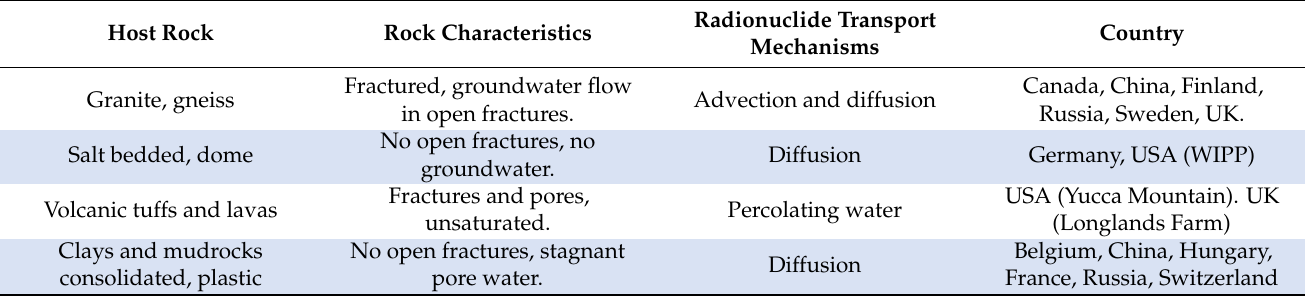
Table 6. Geological formations for deep underground disposal of nuclear waste